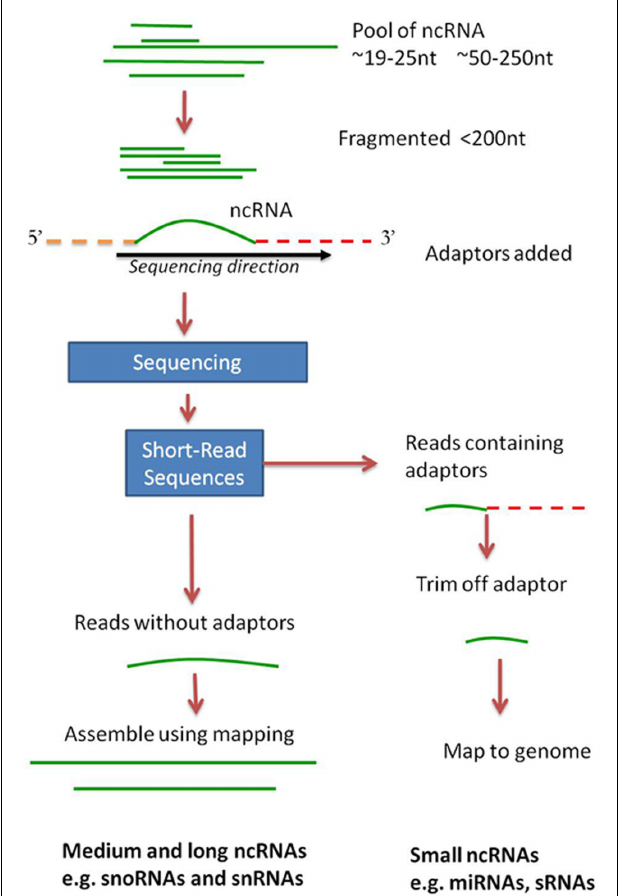
FIGURE 2 |A general approach for using high-throughput sequencing data to search for small and larger ncRNAs. Total RNA can contain ncRNA sequences of different sizes. Small ncRNAs such as miRNAs and siRNAs will produce data containing the ncRNA sequence plus adaptor sequence. Once the adaptor is trimmed off, the sequence is ready for mapping and further genomics.When longer ncRNAs are sequenced, they are fragmented to a predetermined size by the sequencing process. After sequencing they can be assembled by mapping (see text) into their longer sequences.This approach was successfully used for the analysis of ncRNAs from Giardia lamblia (see text for